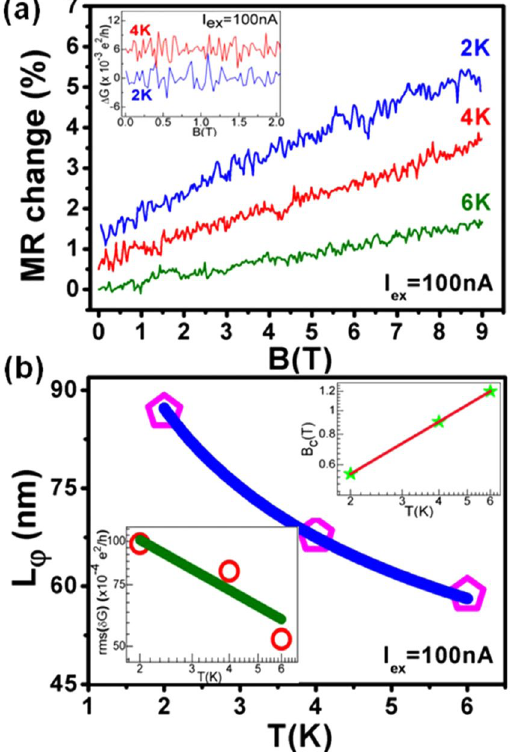
Figure 2. Temperature dependence of UCF for device W3. ( a ) M-R change (%) curves at different temperatures. Resistance shows clear fluctuations with magnetic field for different temperatures at 100 nA excitation current. Amplitude of fluctuations gets reduced with increase in temperature. Inset shows the reproducible M-R fluctuations for different temperatures. ( b ) T − 0.36 phase coherence length decay as a function of temperature. Lower inset shows the slowly decaying UCF magnitude with temperature. An exponential function of δ = rms G cT ( ) a was used, where c = 0.014 ± 0.003and a = − 0.47 was extracted from the fit. Upper inset shows the correlation field values calculated using correlation function at different